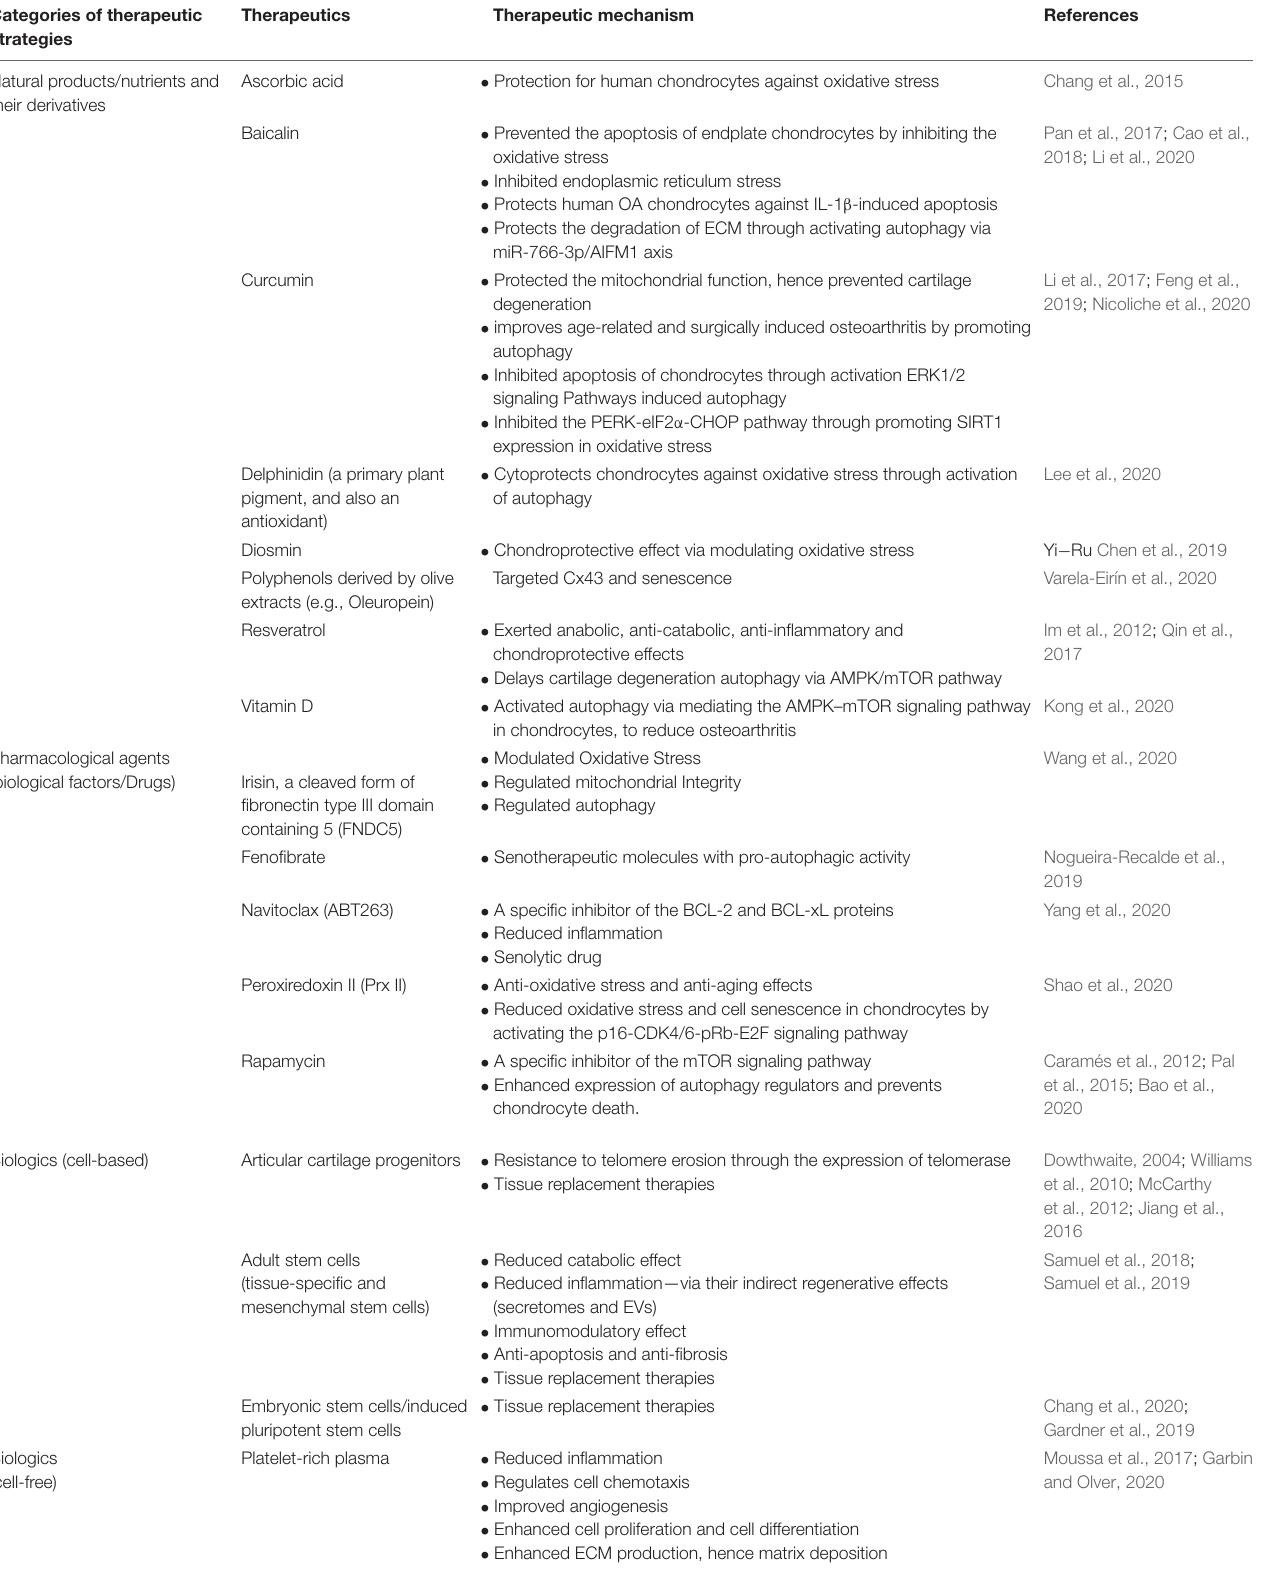
TABLE 1 | Chondroprotective therapeutics and the underlying mechanism of action targeting aging and degeneration associated